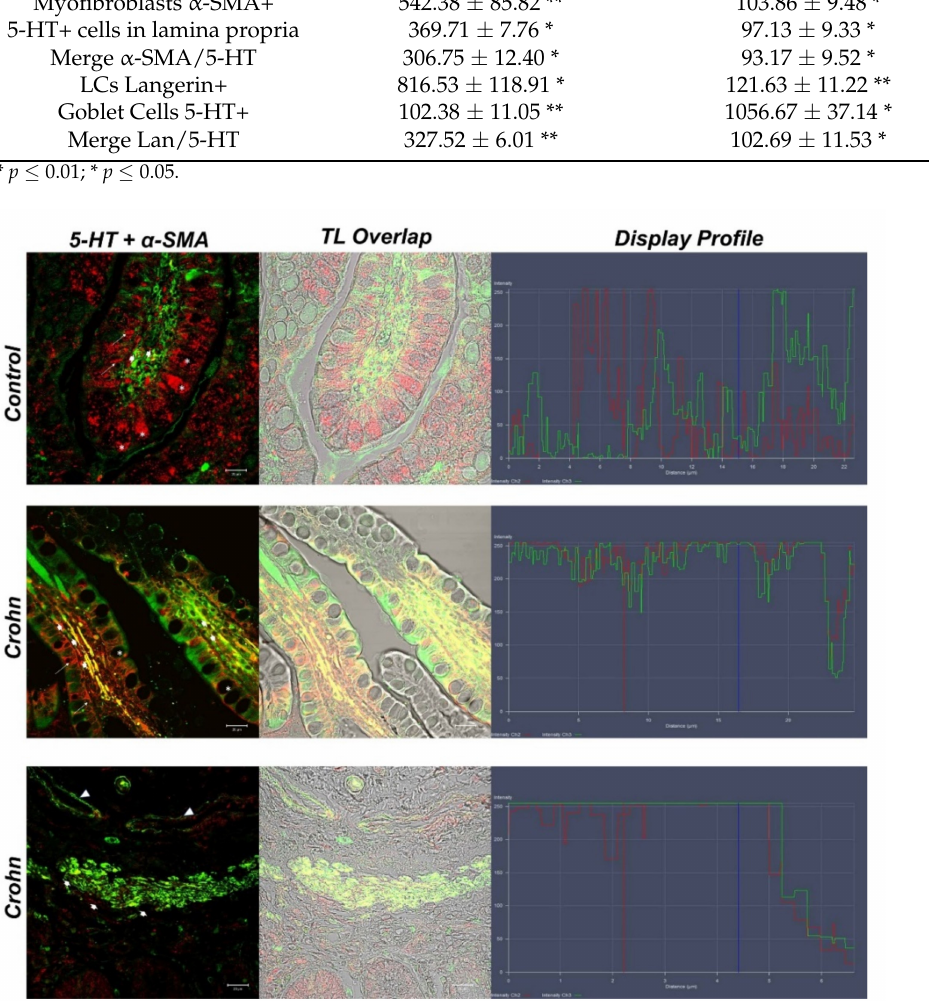
Figure 3. Human intestine, 5-HT/ α -SMA colocalization, 20 × , scale bar 20 nm. Merge photomicro- graphs indicate the double localization of two antibodies in myofibroblasts, in which it is evident that the overlap (yellow fluorescence) concerns the CD samples rather than in the healthy intestine. In the control section 5-HT highlighted the goblet cells cytoplasm (*). A cluster of subepithelial myofibroblasts in the lamina propria colocalized with 5-HT and α -SMA (large arrows), blood vessels (arrowheads). The graph represents the “display profile” function of the laser scanning microscope to show the intensity profile of detected